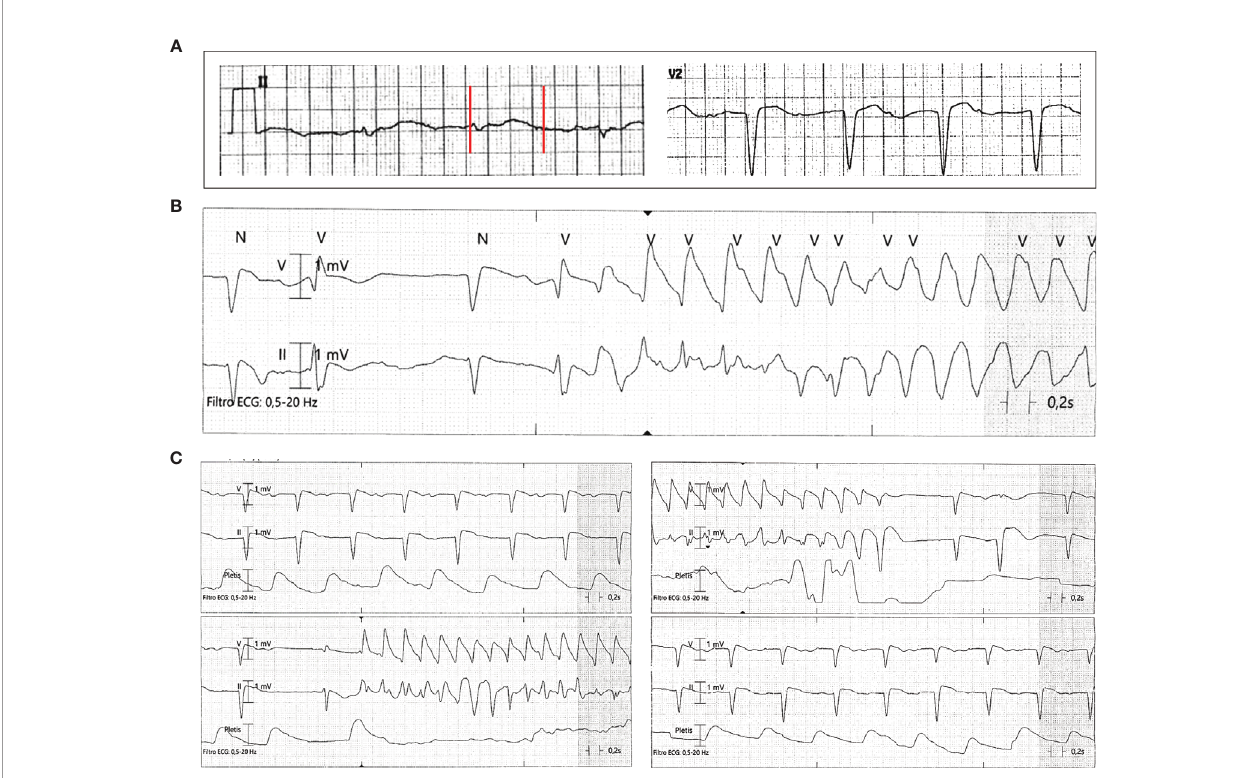
FIGURE 4 | ECG fi ndings in patient 4: (A) QTc prolongation (640 ms); (B , C) recurrent episodes of nonsustained Torsades de Pointes. Red vertical lines in lead II show the QT